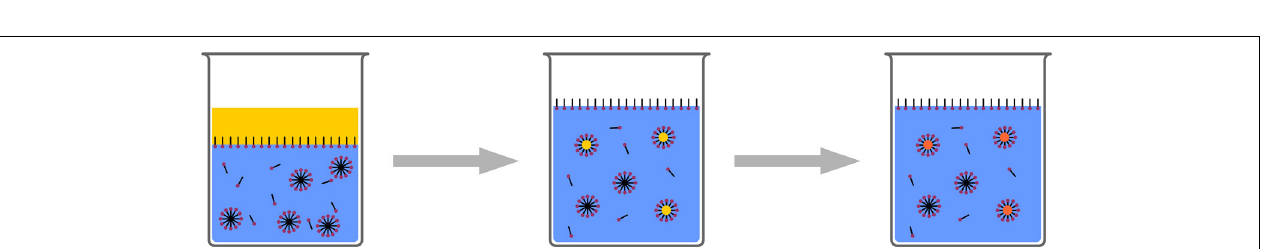
FIGURE 8 | Schematic representation of classic emulsion polymerization.